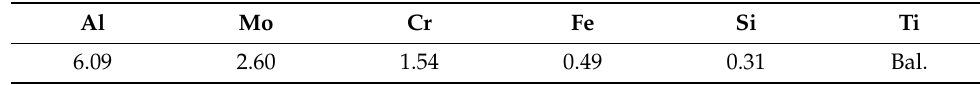
Table 1. Chemical composition of TC6 titanium alloy